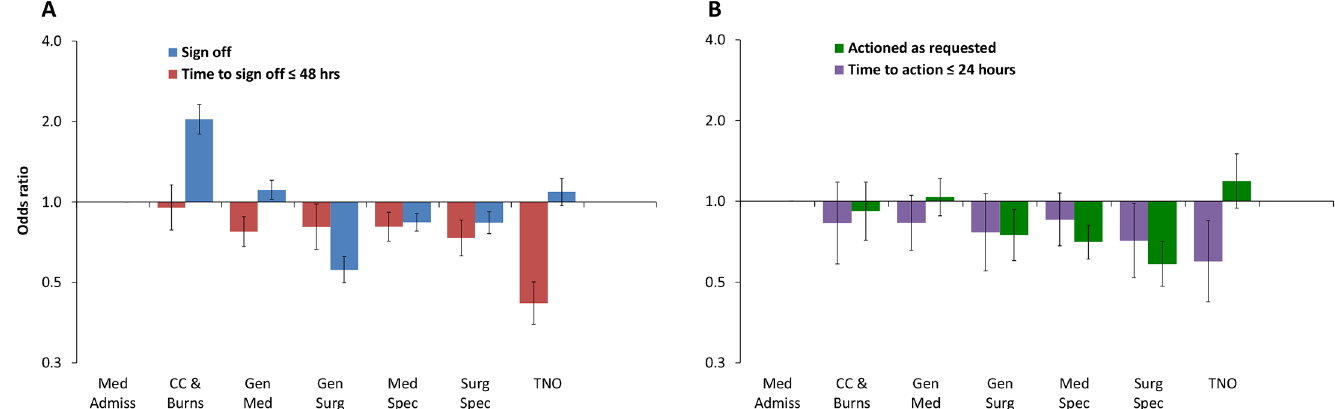
Fig 6. GEE model for speciality. A: Sign-off and time taken to sign-off in (cid:1) 48 hours; B: Action and time to action as requested in (cid:1) 24 hours. ORs (95% CI) from the GEE model described in S4 Appendix. Medical Admissions is the reference categoryCC: Critical Care; Med: Medicine; Surg: Surgery; Spec: Specialities; TNO: Trauma and